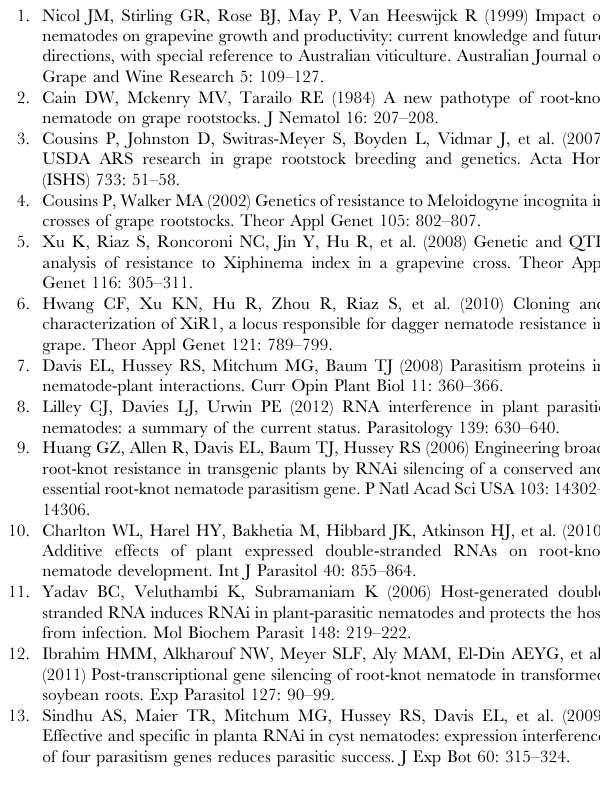
Table S1 Mean fresh hairy root weight and numbers of nematode eggs per hairy root and per gram root observed in transgenic grape hairy root lines infected with root-knot nematodes.